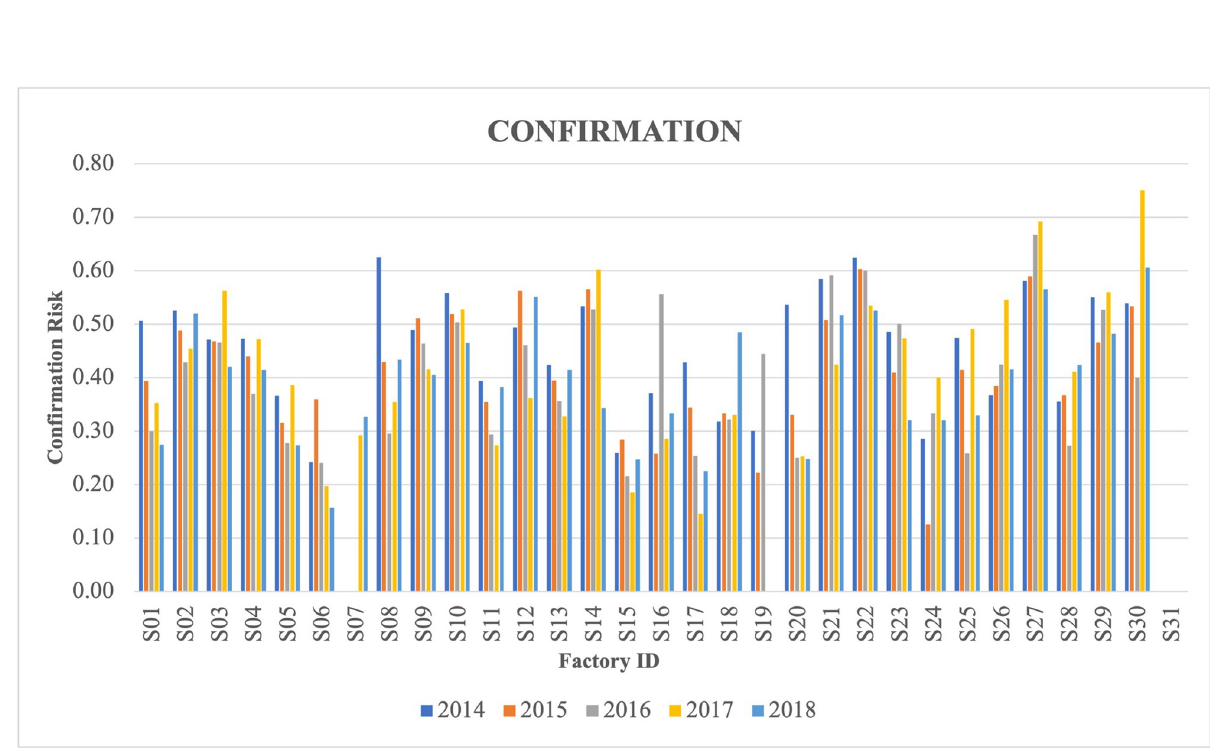
Fig 2. Confirmation risk (proportion) of lesions submitted by 31 Irish factories per year (2014–2018).